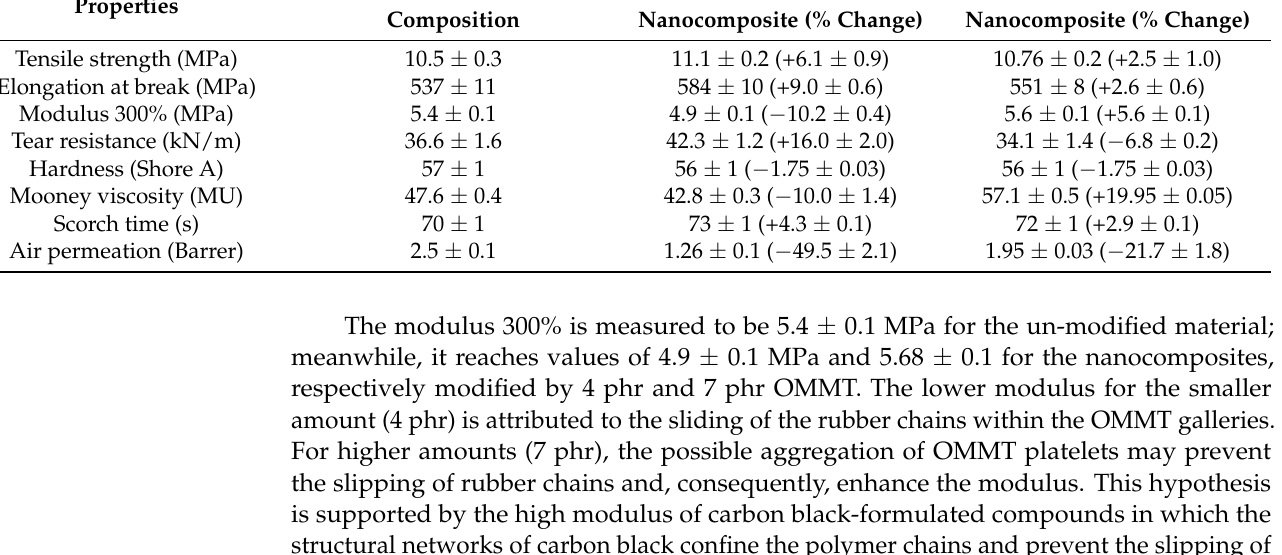
Table 2. The effect of OMMT on the physical and mechanical properties and the air permeation of the inner liner composition.